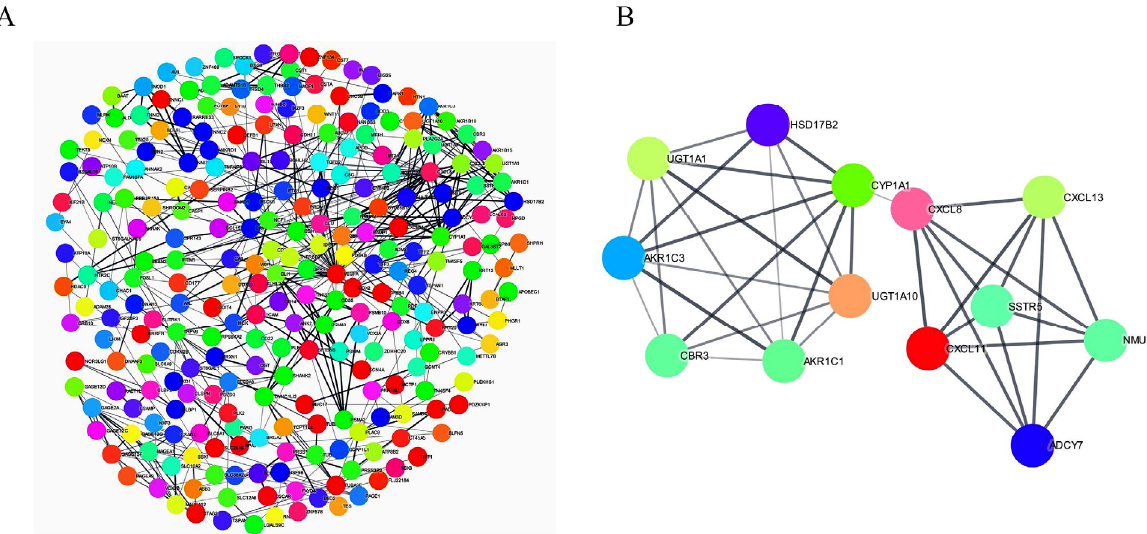
Figure 4. Protein–protein interaction network construction. ( A ) Protein–protein interaction network of differentially expressed genes, constructed using Cytoscape, showing 371 nodes with 483 edges. ( B ) Topmost significant module in PPI network analyzed by MCODE (score =